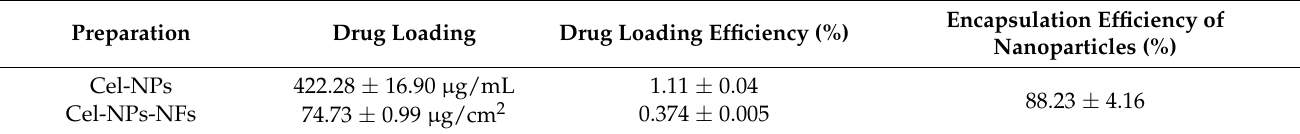
Table 1. Drug loading and encapsulation efficiency of different